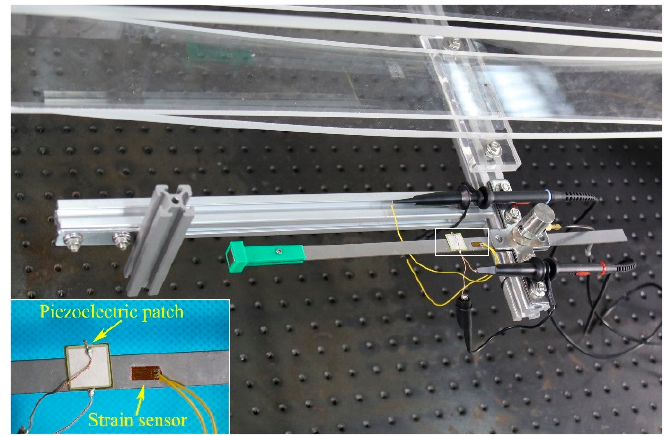
Figure 7. Prototype of the LPEH.